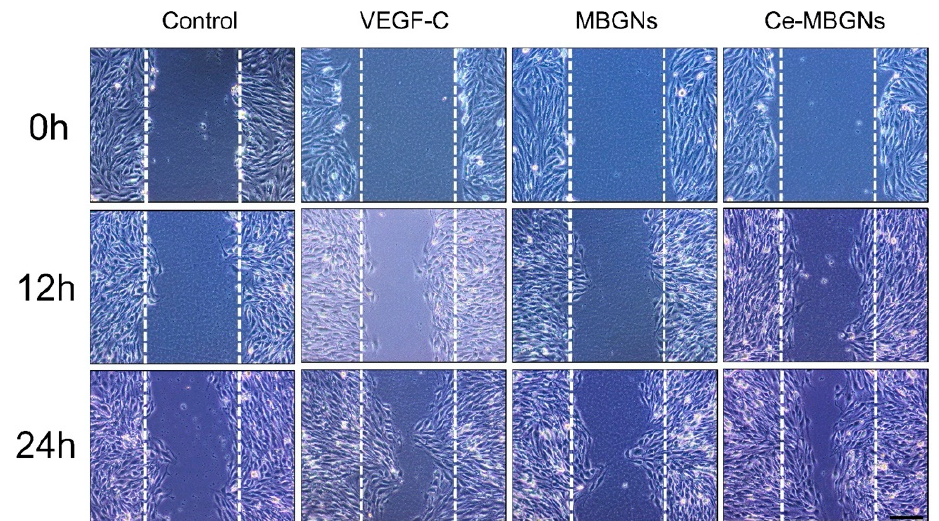
Figure 4. The scratch wound healing assay showing the migration ability of LECs cultured with different conditioned culture media, namely VEGF-C (50 ng/mL), MBGNs (1 wt/v% extract), and Ce-MBGNs (1 wt/v% extract). Scale bar = 200 µ m. The experiment was performed at least in triplicate independently. The white dotted lines indicate the area of initial injury (scratch).